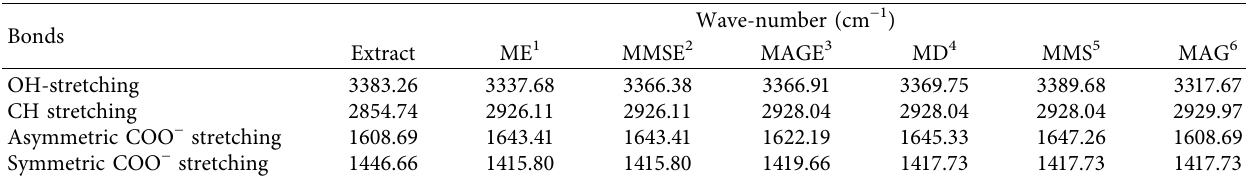
Figure 5: DSC curves of the extract and microcapsules. maltodextrin (MD), Arabic gum (AG), modified starch (MS). Table 5: Infrared spectra’s characteristic peaks of extract and microcapsules.